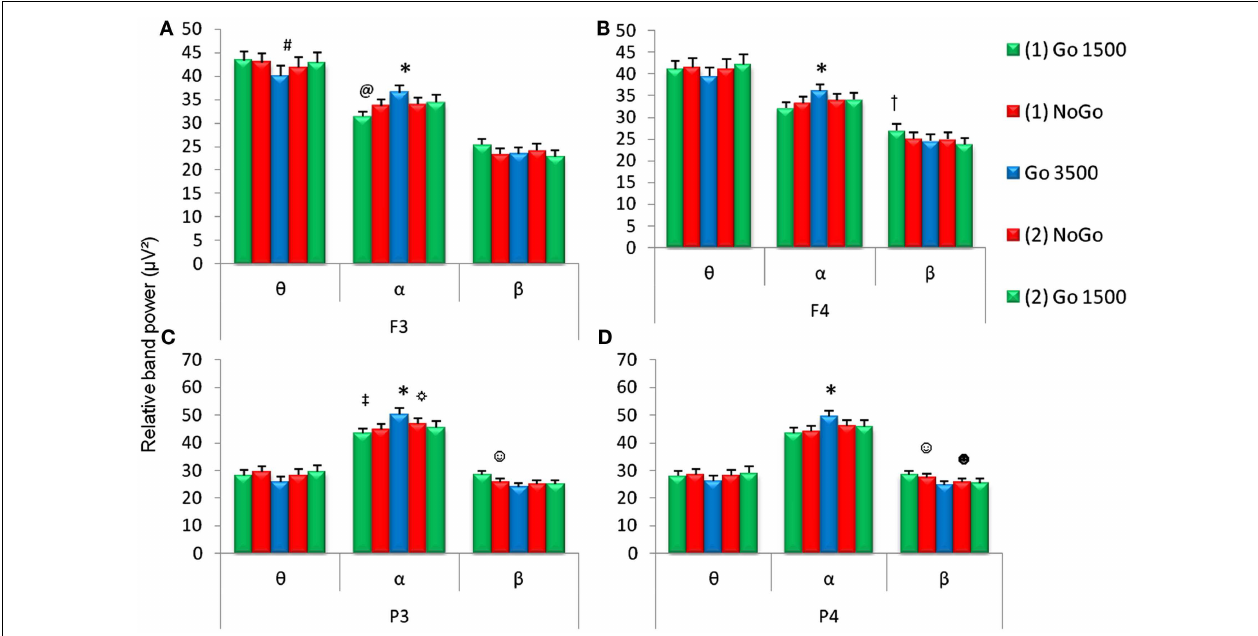
compared to the second no-go and second go condition. (B) † F 4 β band power was higher during the first go condition compared to the second no-go and second go condition). ‡ P 3 α band power was lower during the first go condition compared to the second no-go condition. P 3 α band power was lower during the second go condition compared to the go 3500 condition. Parietal (C,D) β band power was higher during the first no-go condition compared to the go 3500 condition. (D) P 4 β band power was lower during the second go condition compared to the first no-go condition ( p < 0.0071, n = 53, mean ±